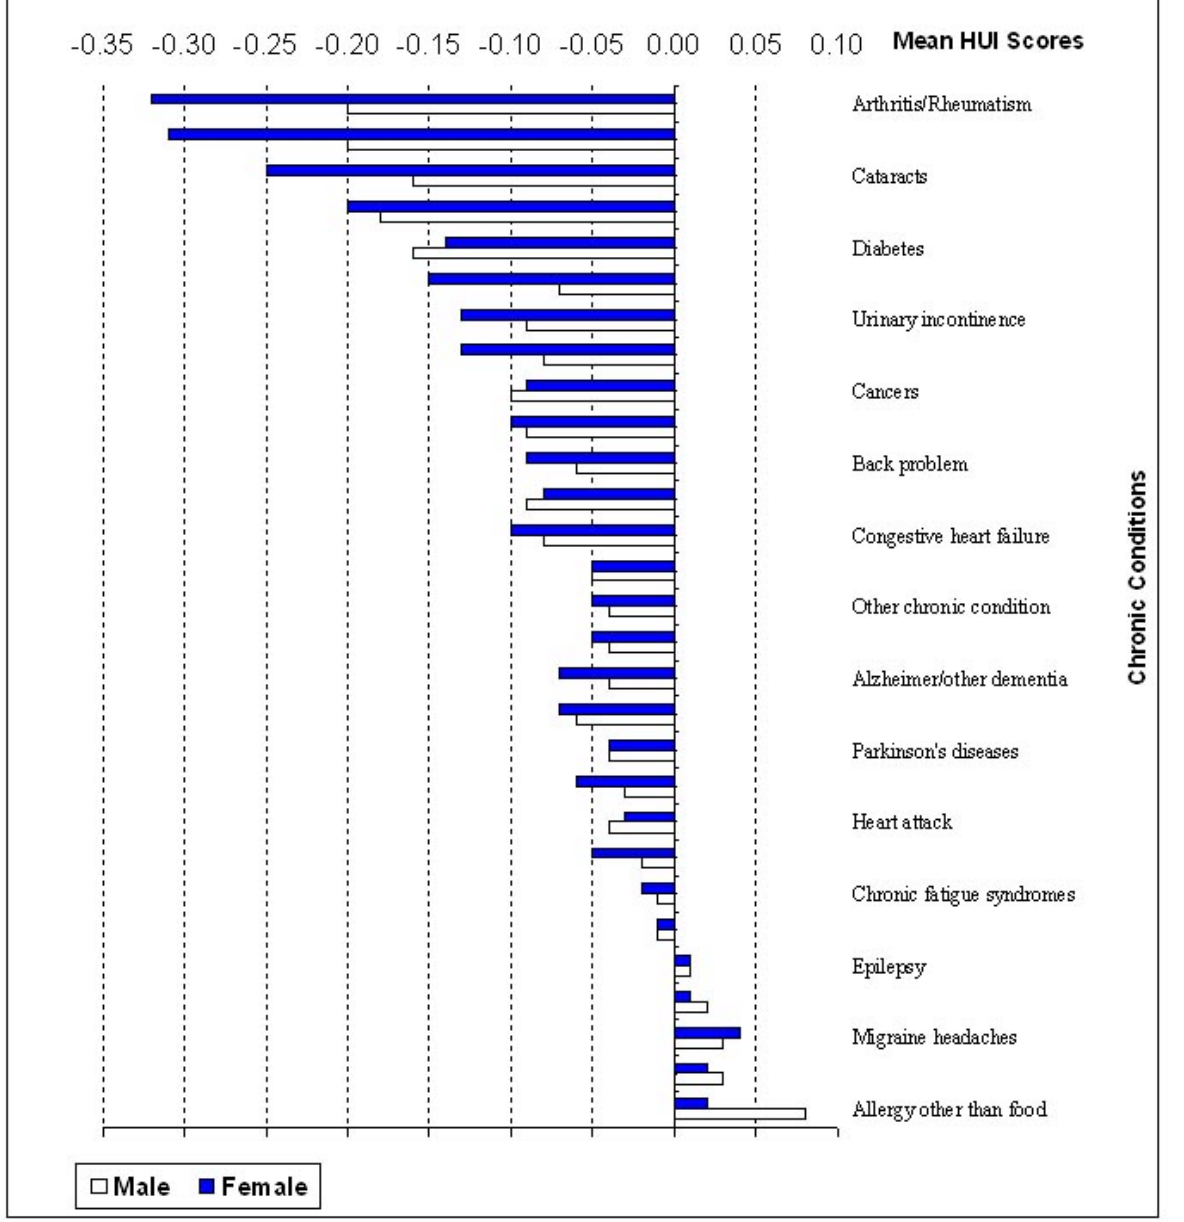
FIGURE 1. Impact of selected chronic conditions on HRQL by gender and household population aged 12 and over. CCHS Data, 2000–01.